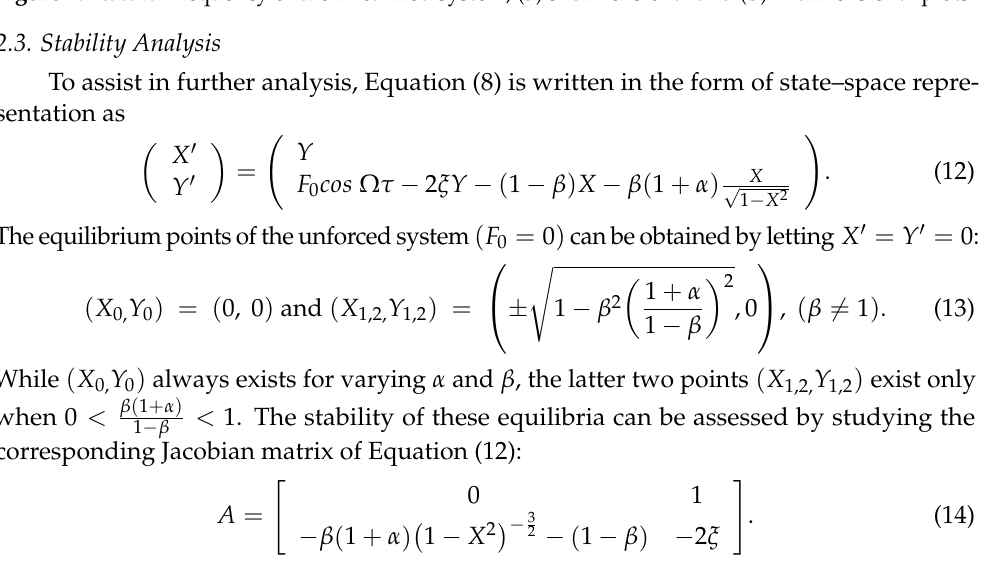
Figure 4. Natural frequency of the linearized system; ( a ) 3–dimensional and ( b ) 2–dimensional